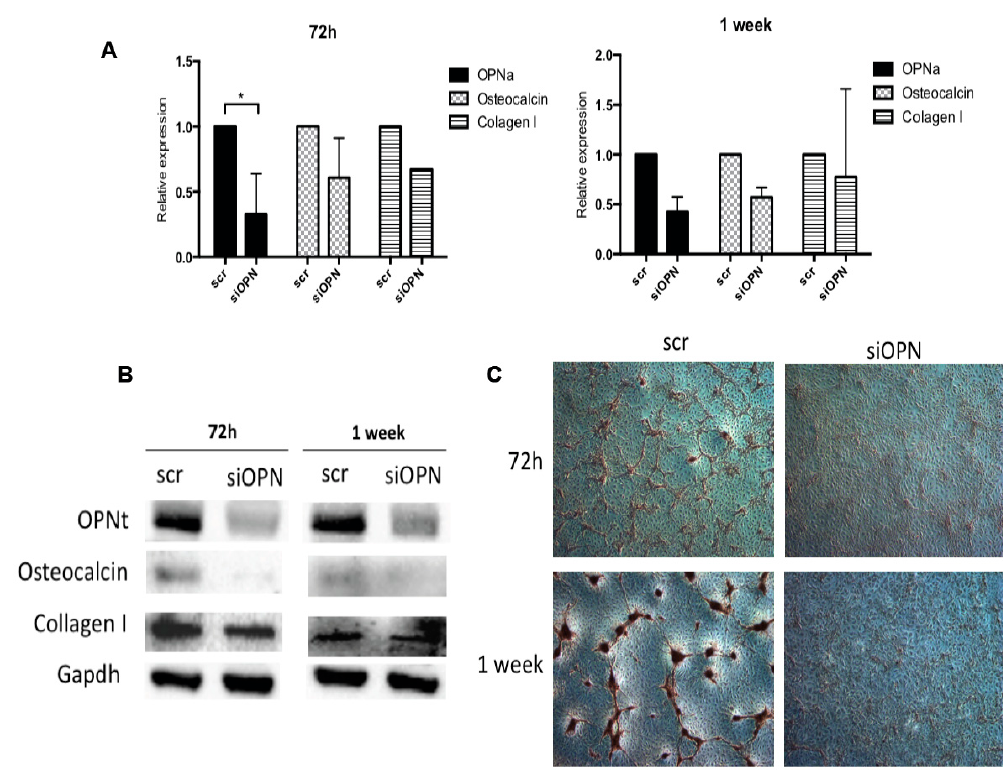
Figure 4. OPN silencing in TPC-1 cells promotes downregulation of OPNa, osteocalcin, collagen type 1 mRNA, and protein expression and inhibition calcification deposits. ( A ) OPNa, osteocalcin, and collagen type I mRNA expression levels were measured by real time PCR in TPC-1 thyroid cell line after 72 h and 1 week of cell culture. Cells were treated with 100 nM of small interfering RNA (siRNA) for tOPN and 100 nM of siRNA negative control (scr), corresponding to scr-siRNA, for 72 h and 1 week. ( B ) Western blot was performed for OPN, osteocalcin, and collagen type I proteins after OPN silencing. Representative GAPDH expression is shown. The protein levels in treated cells were evaluated in duplicate. ( C ) Representative images 72 h after OPN silencing in TPC-1 cell line and for the siRNA negative control (scr,) are shown. Matrix calcification was detected with Alizarin Red staining after 72 h and 1 week of OPN silencing and the siRNA negative control (scr). Dark brown areas correspond to ECM rich in calcium